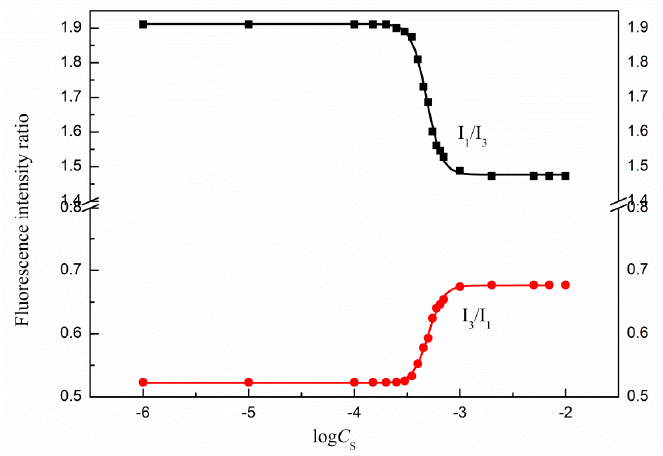
Figure 14. The ratios of I 1 / I 3 and I 3 / I 1 for pyrene vs. the logarithm of TS-OE12 concentration (log C S ) at 298 K.